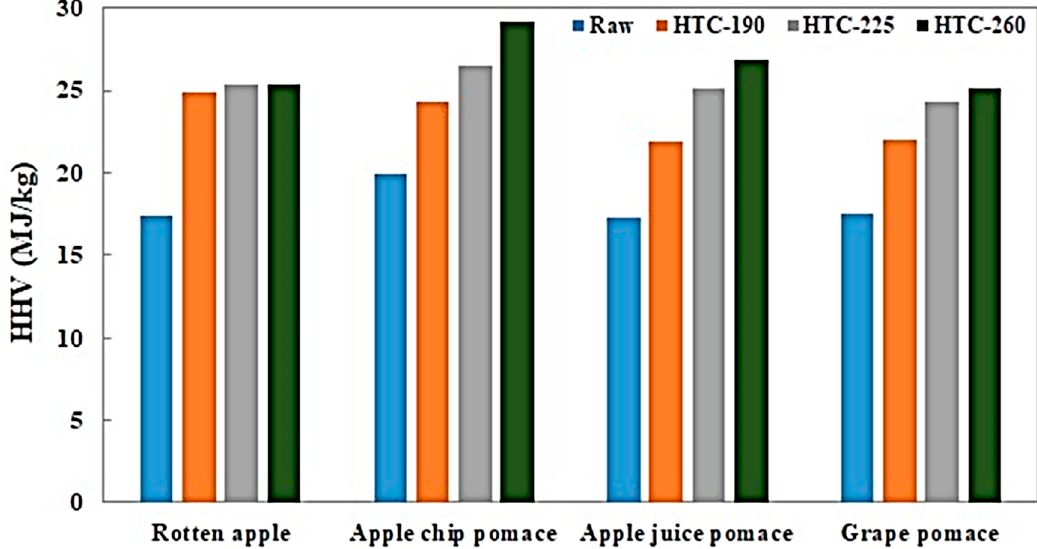
Figure 2. Higher heating value of raw and treated samples.